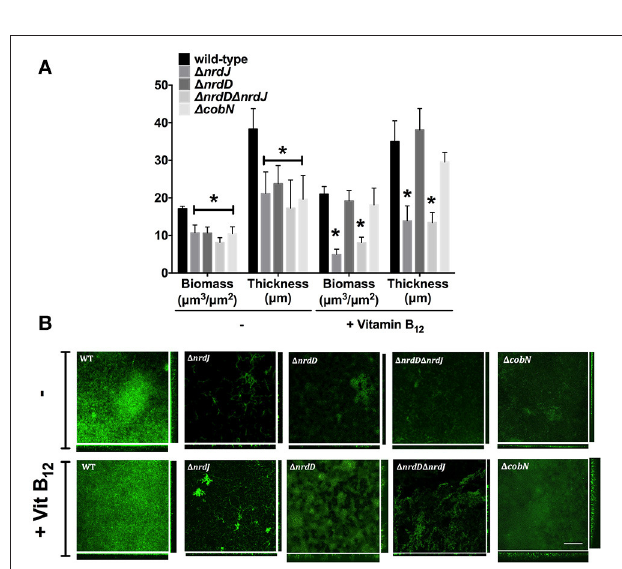
FIGURE 5 | Vitamin B 12 enables P. aeruginosa biofilm formation though class II RNR activity. (A) The continuous-flow cell biofilm of P. aeruginosa PAO1 wild-type, 1 nrdJ, 1 nrdD , 1 nrdJ 1 nrdD, and 1 cobN strains was grown for 5 days in MM ± vitamin B 12 (1 µ g/ml). Biomass and thickness were calculated using COMSTAT software. Data are the average of three independent experiments. Asterisks over bars (*) indicate statistical differences ( p < 0.005 in pairwise t- test calculated with GraphPad 6.0). (B) Pictures of the sum and the orthogonal views of biofilms stained with the LIVE/DEAD BacLight